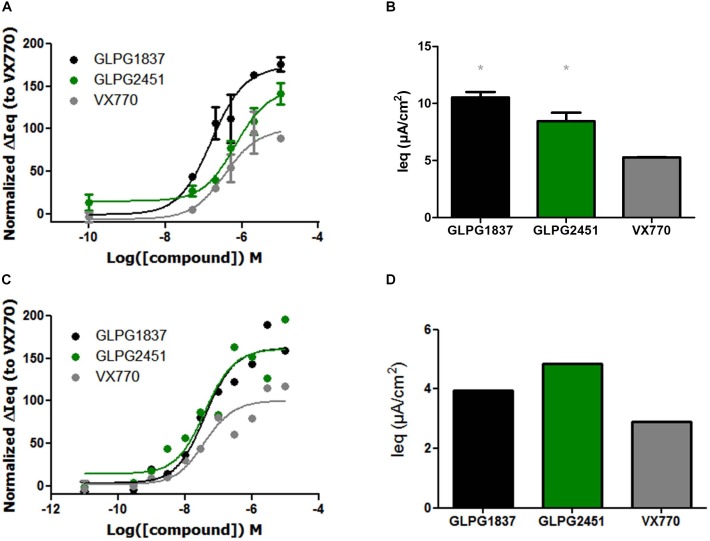
Effect of a concentration range or maximal efficacy at 3 μM of GLPG1837, GLPG2451, and VX770 on G551D/F508del (A,B) and R334W/F508del (C,D) primary human bronchial epithelial cells. (n = 2 for each tested concentration in G551D/F508del, n = 1 for each tested concentration in R334W/F508del), data in (A,C) was normalized to VX770. ∗ denotes a P < 0.05 compared to VX770 treatment. (A) Contains data for VX770 and GLPG1837 adapted with permission from Van der Plas et al. (2018). Copyright (2018) American Chemical Society.